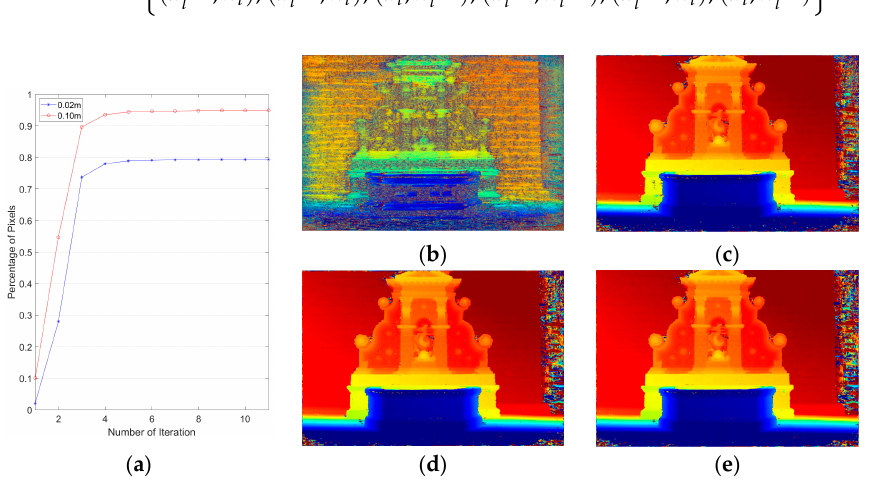
Figure 5. The relationship of accuracy and iteration number. ( a ) is the percentage of pixels with absolute errors below 2 cm and 10 cm. ( b – e ) are the depth maps with iterations of 1, 3, 5, and 7. Secondly, the number of combinations with the depth and normal hypotheses is re- duced in the plane refinement procedure according to the matching cost. The current best